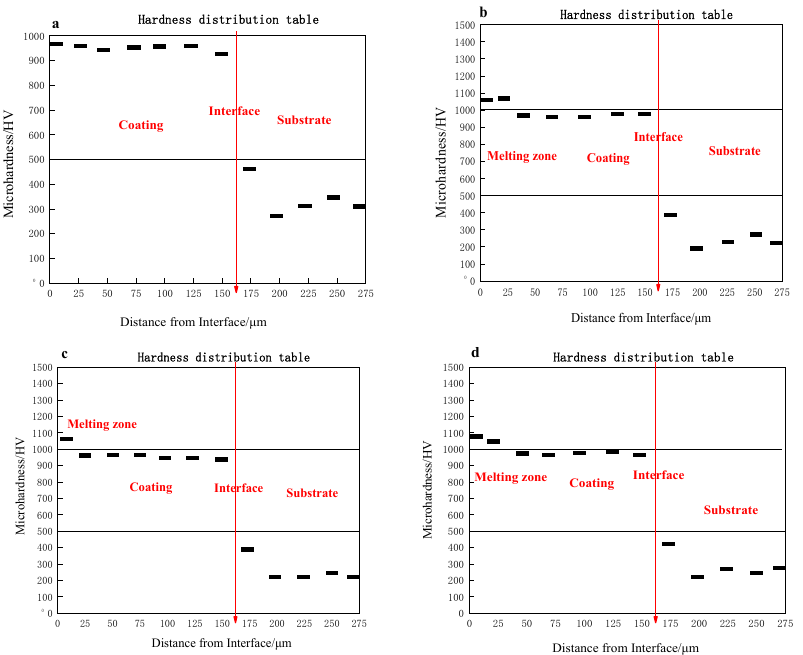
Figure 7. Hardness variation through the thickness direction of the coatings: ( a ) 1#; ( b ) 2#; ( c ) 3#; ( d ) 4#.